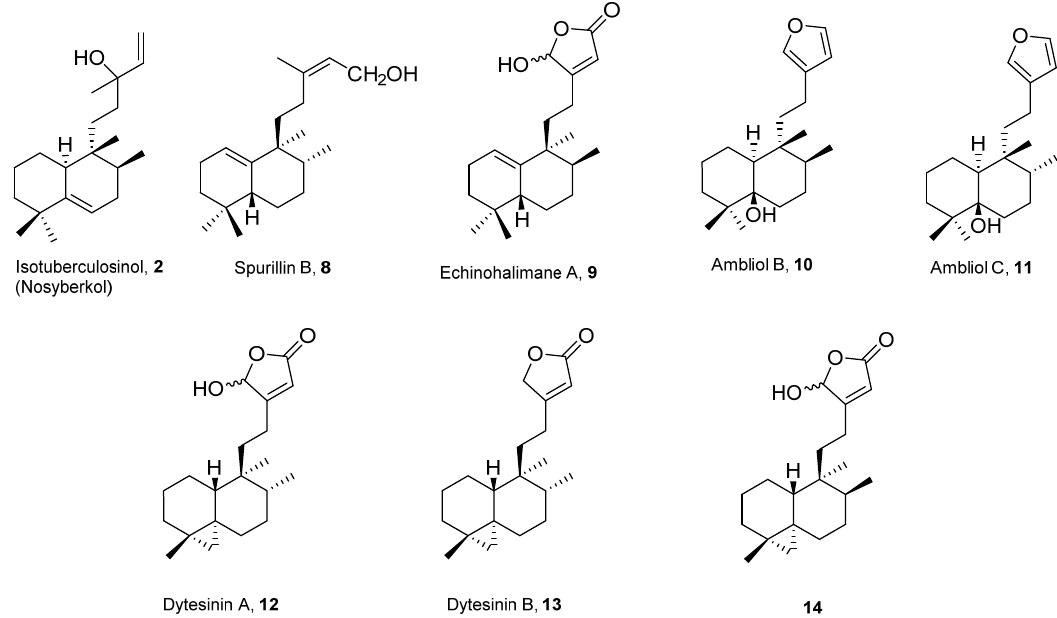
Figure 5. Halimanes of marine origin. Table 1. Natural sources and activities of marine origin halimanes.